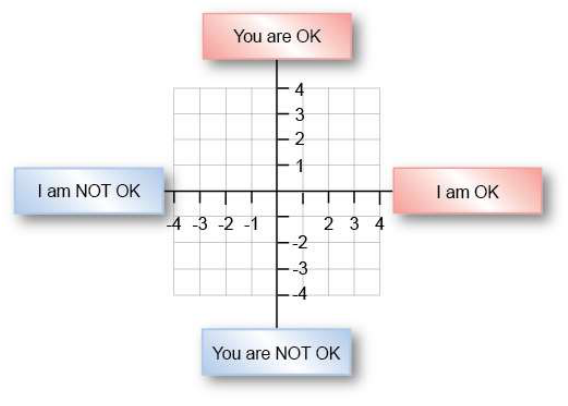
Figure 3: Four types of Existential Position, measured from 1 to 4 (on the positive parts of axis) and -1 to -4 (on the negative ones). I-scale expressed in the y-axis and You-scale expressed in the